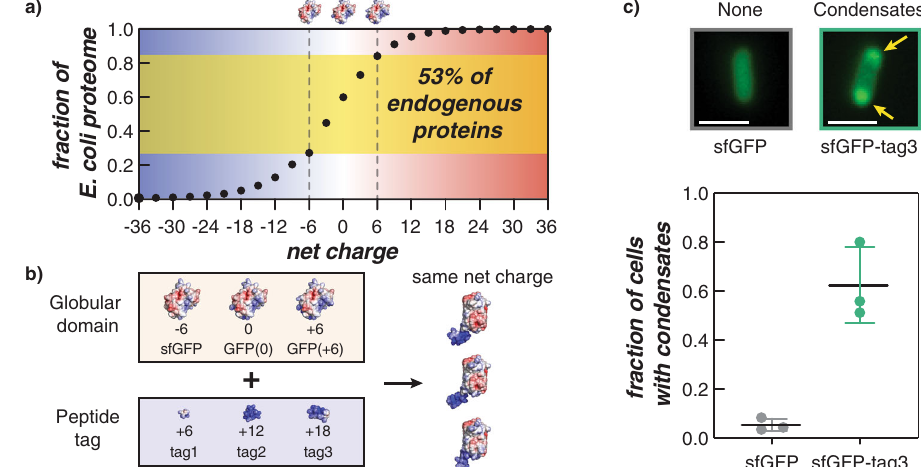
Fig. 1 | Cationic peptide tags promote the formation of biomolecular con- densatesin E.coli .a Thecumulativedistributionofoverallnetchargeinthe E.coli proteome reveals that the majority of proteins are not highly charged. 53% of proteins have an expected net charge between − 6 and +6. b A schematic sum- marizingtheGFPvariantsusedinthisstudytounderstandhowtheproteinglobular domain and cationic peptide tags affect condensate formation in bacterial cells. Electrostatic surface maps of the globular and peptide domains as well as fusions were generated in PyMol from predicted structures. A detailed description of the method to generate these is included in the Supplementary Information.